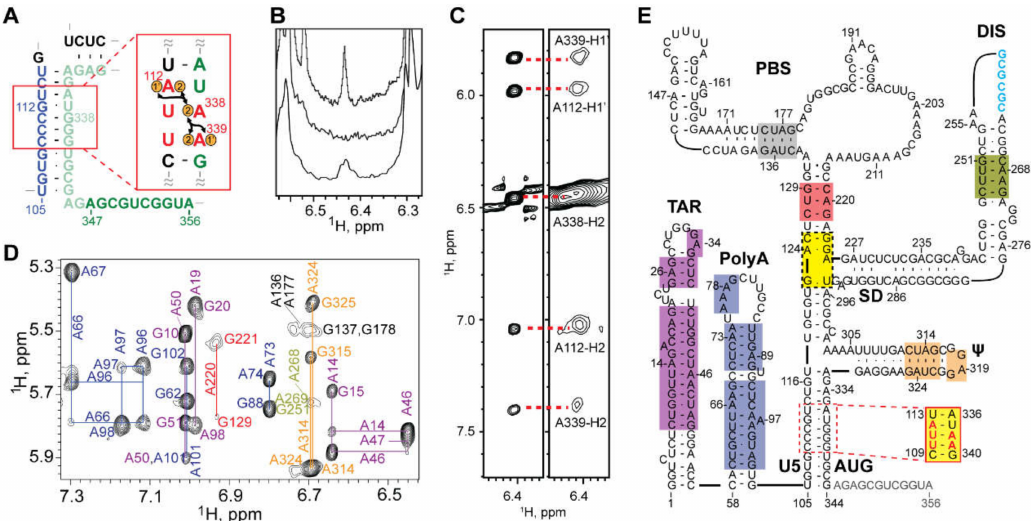
Figure 8. NMR studies of the intact, dimeric HIV-1 NL4-3 5 (cid:48) -leader. ( A ) Illustration depicting mutations in the lr-AID substitution and 1 H- 1 H NOEs. ( B ) Region of 1D 1 H NMR spectra showing (top) the native TAR A46-H2 signal, (middle) A46G substitution, (bottom) A338-H2 signal observed for the lr-AID substitution. ( C ) 2D 1 H- 1 H NOESY spectra of the same A338-H2 signal observed an isolated U5:AUG hairpin (left) and intact dimer (right) containing the lr-AID substitution. ( D ) Region of the 2D 1 H- 1 H NOESY spectrum of A 2r G r C r -labeled dimeric HIV-1 NL4-3 RNA; color-coding matches the elements shown in ( E ). ( E ) Secondary structure of the HIV-1 NL4-3 in its DIS-exposed, dimer-promoting state. Color-shaded boxes denoted resolved and assigned 2D 1 H- 1 H NOESY signals; yellow denotes sites that were only assignable in mutant constructs using truncated constructs or lrAID